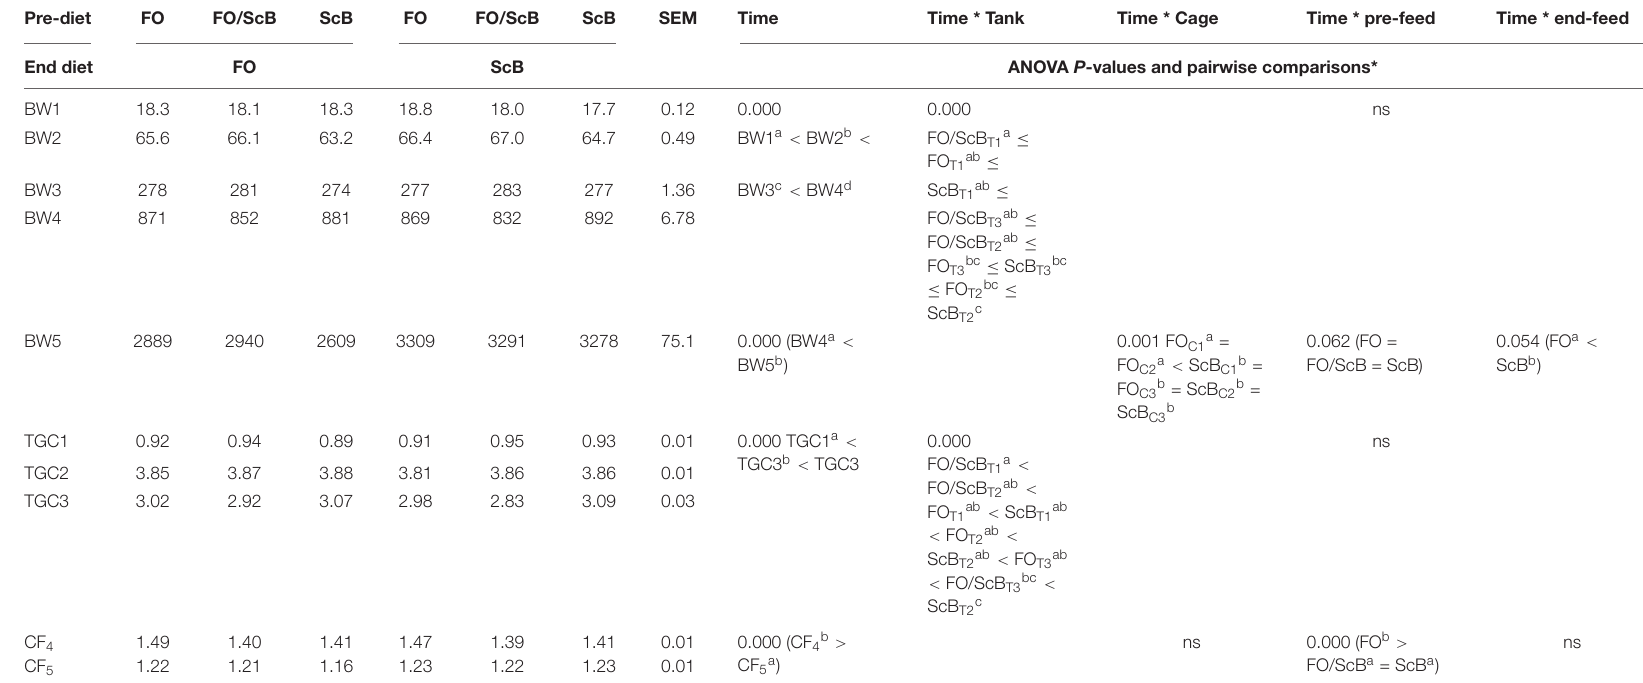
Values are means (n = 3 tanks/cages per feeding treatment) and standard error of the mean (SEM). Wilks’ Lambda multivariate test significance (P) values are following repeated measures ANOVA for BW (BW1–4) and TGC (TGC1–3) during the tank phase (T: n = 9) and BW (BW4–5), TGC (TGC3–4), and CF (CF3–4) from the end of the tank phase to slaughter in the cages (C: n = 6); Pairwise comparisons by Duncan’s post hoc test (P < 0.05). *Coded values in the same cell not sharing common superscript letter are significantly different as determined by repeated measures ANOVA and separated by pairwise comparisons by Duncan’s post hoc test (P < 0.05); ns,